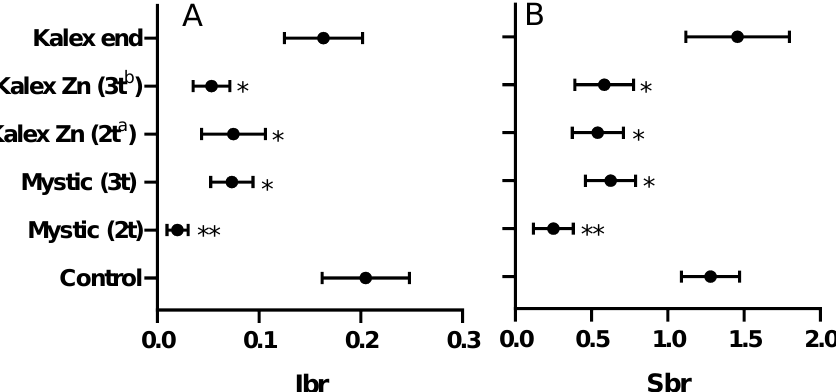
Figure 2. Incidence ( A ) and severity ( B ) of brown rot (Ibr and Sbr, respectively) of chestnut fruits collected from trees in the six treatment theses in 2020. Bars represent the SEM. Statistical differences with the untreated control at Dunnett’s multiple comparisons ( A ) and Holm–Sidek’s multiple com- parison ( B ) tests are evidenced by * = p < 0.05, ** = p < 0.01. a two treatments (June and July), b three treatments (June, July and August).